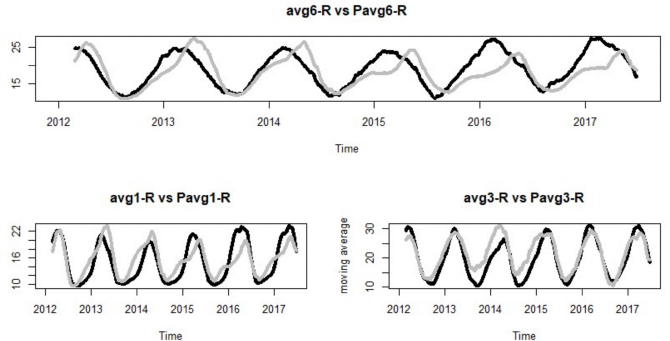
Figure 42. Moving averages ( ◦ C) for predicted water temperatures at the recorded water level (black) and at full dam steady-state